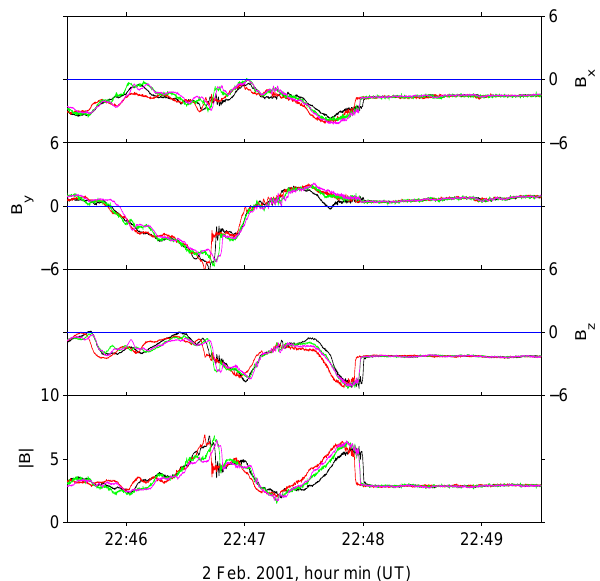
Fig. 13. Magnetic field data at 22 vectors/s in GSE coordinates, in the same format at Fig. 5. The data show an abrupt transition from a region populated by ULF waves and shocklets, to undisturbed solar